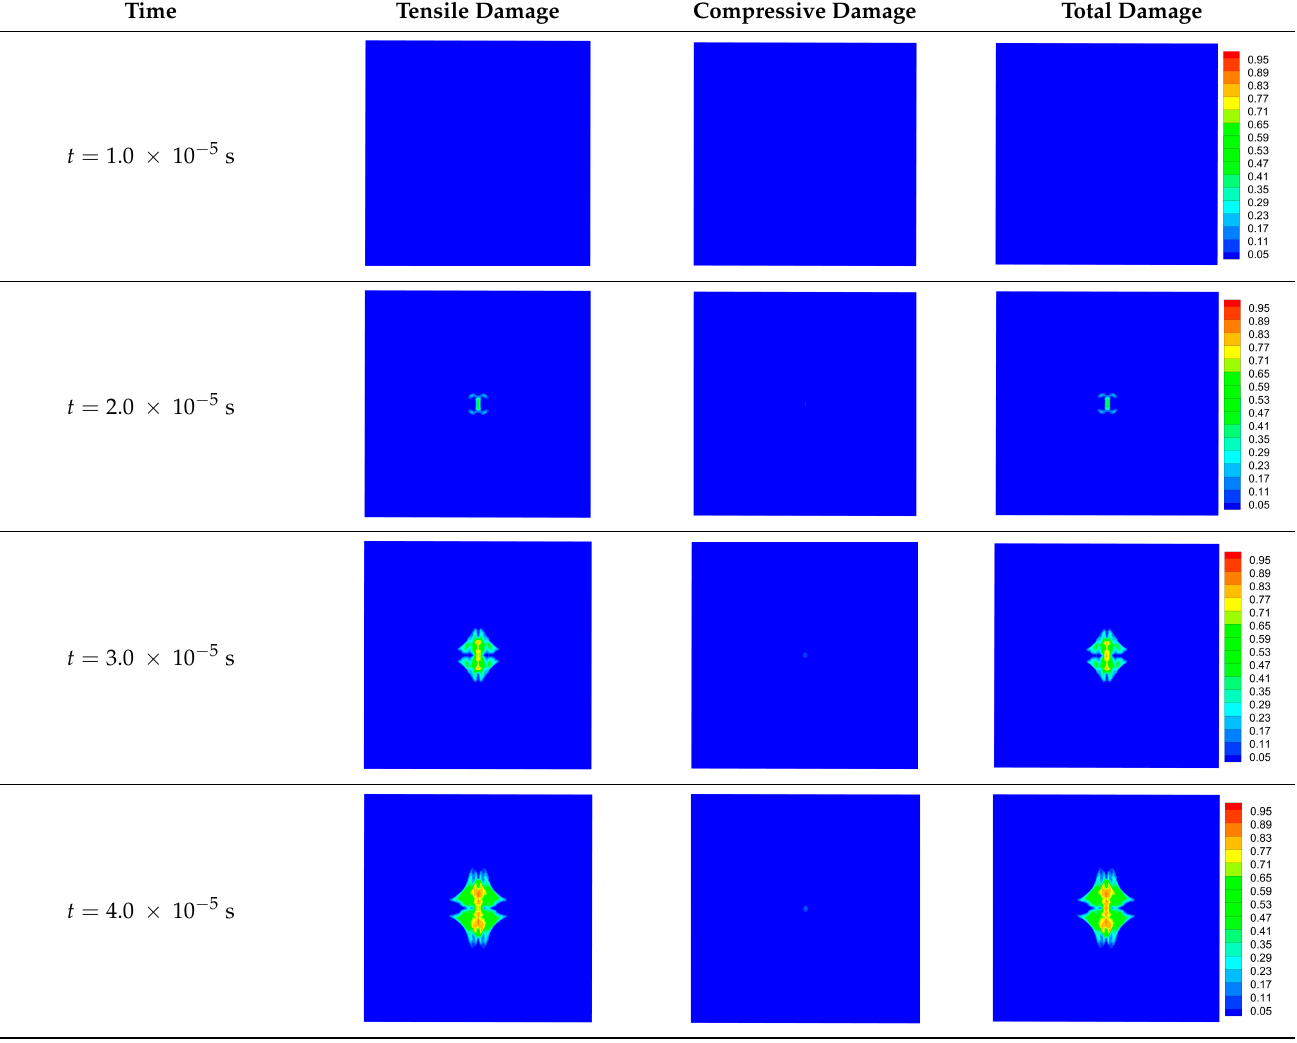
Table 3. Laminate damage evolution process with time (rear surface).